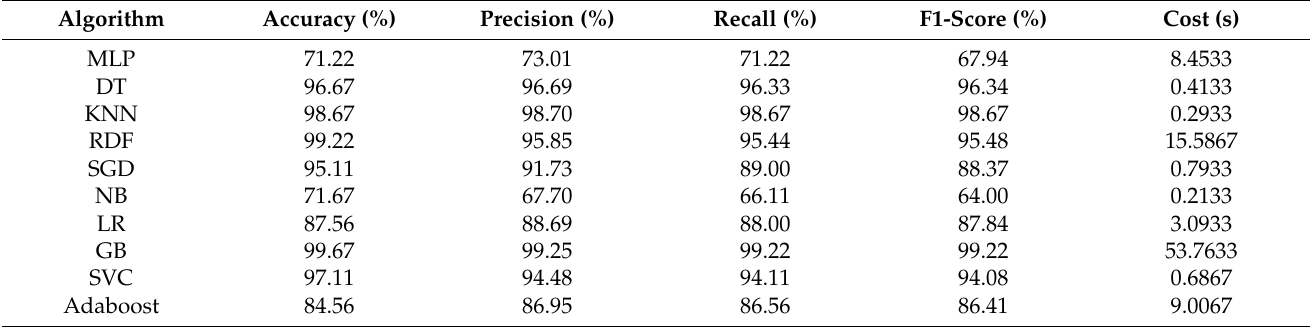
Table 11. Global performance comparison of ML models using combination of (RS) and (Q) features.